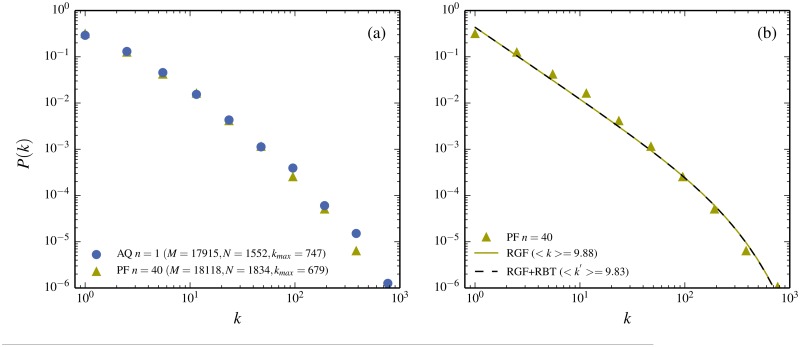
Comparison between two different texts of approximately equal length written by different authors in Chinese characters.(a) A Q Zheng Zhuan (filled dots) is compared to the 40th part of Ping Fan De Shi Jie (filled triangles). Note that the two data sets almost completely overlap. This means the difference in the frequency distribution between A Q Zheng Zhuan and Ping Fan De Shi Jie is just caused by the difference in length of the two novels. Furthermore (b) illustrates that this length difference is rather trivial because it just the frequency distribution you get when randomly removing 97.5% of the words from Ping Fan De Shi Jie (dashed curve).